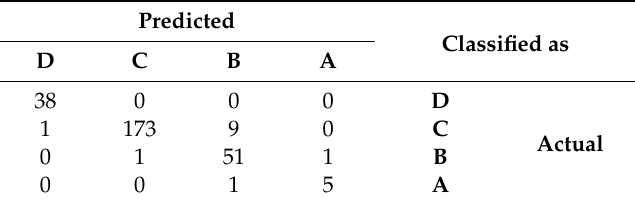
Table 5. Confusion matrix of the decision tree for a natural rough